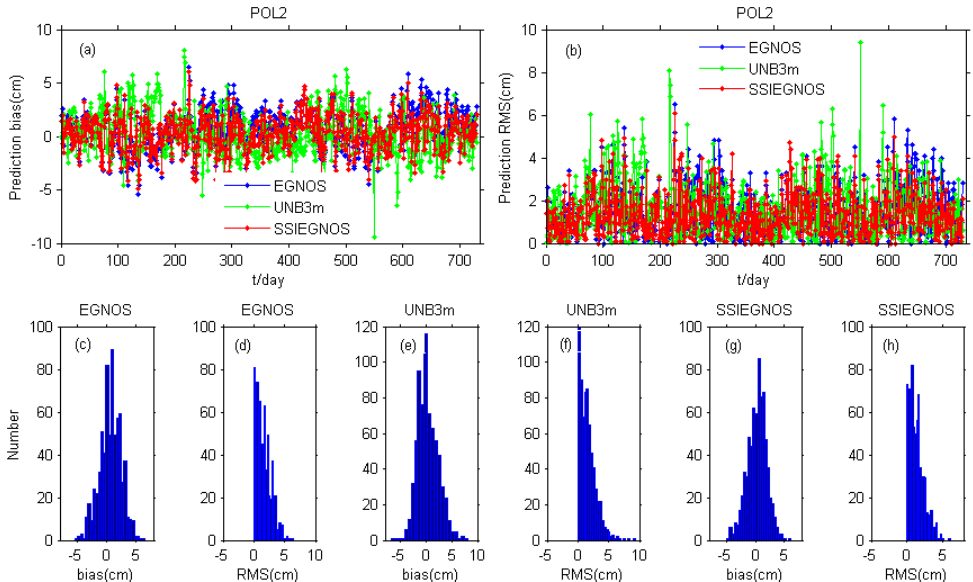
Figure 14. ( a , b ) Time series of daily predicted bias and RMS error from 2011–2012 at the POL2 site. The blue line denotes the EGNOS model, the green line denotes the UNB3m model, and the red line denotes the SSIEGNOS model. ( c – h ) Histograms of the daily predicted bias and RMS error from 2011–2012 for the three models.